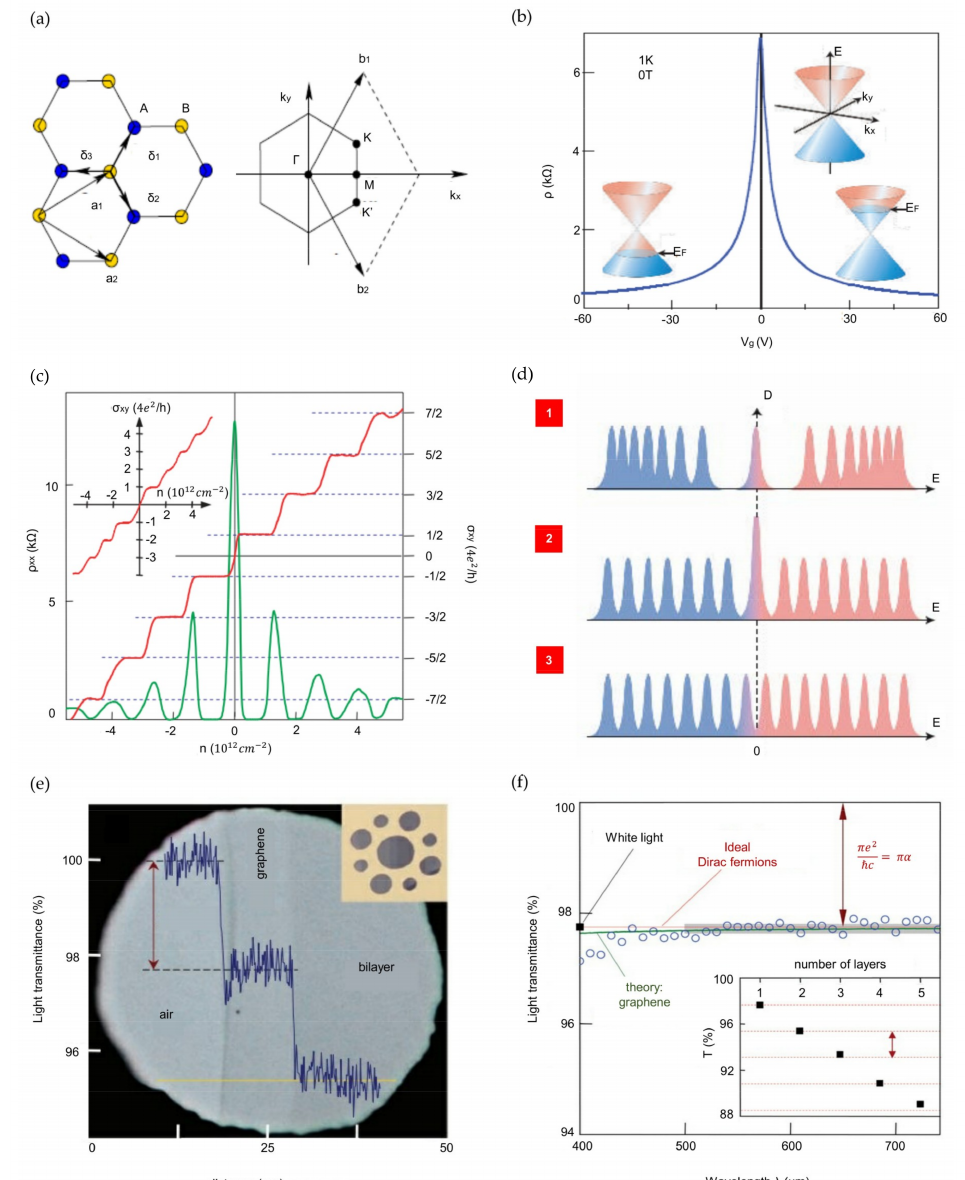
Figure 1. Electronic and optical properties of graphene, ( a ) Hexagonal lattice structure (left) and its Brillouin zone (right); ( b ) Graph of the ambipolar electric field effect of single-layer graphene. The inset indicates the change in Fermi energy E F in response to the changing gate voltage V g in the conical low-energy spectrum E (k); ( c ) Hall conductivity σ xy (red) and longitudinal resistivity ρ xx (green) of graphene versus carrier concentration. The inset shows σ xy in double-layer graphene; ( d ) Three examples of Landau quantization in graphene. D is density of states; ( e ) Image of a 50- µ m diameter aperture covered partly by graphene and its bilayer. (Inset) The designed sample; ( f ) The open circles show the transmittance spectrum of single-layer graphene. (Inset) Black squares indicate the transmittance of white light versus the number of graphene layers; (a) Reproduced with permission from [13]. Copyright Reviews of Modern Physics, 2009. (b), (d) Reproduced with permission from [14]. Copyright Nature Materials, 2007. (c) Reproduced with permission from [7]. Copyright Nature, 2005. (e), (f) Reproduced with permission from [20]. Copyright Science,